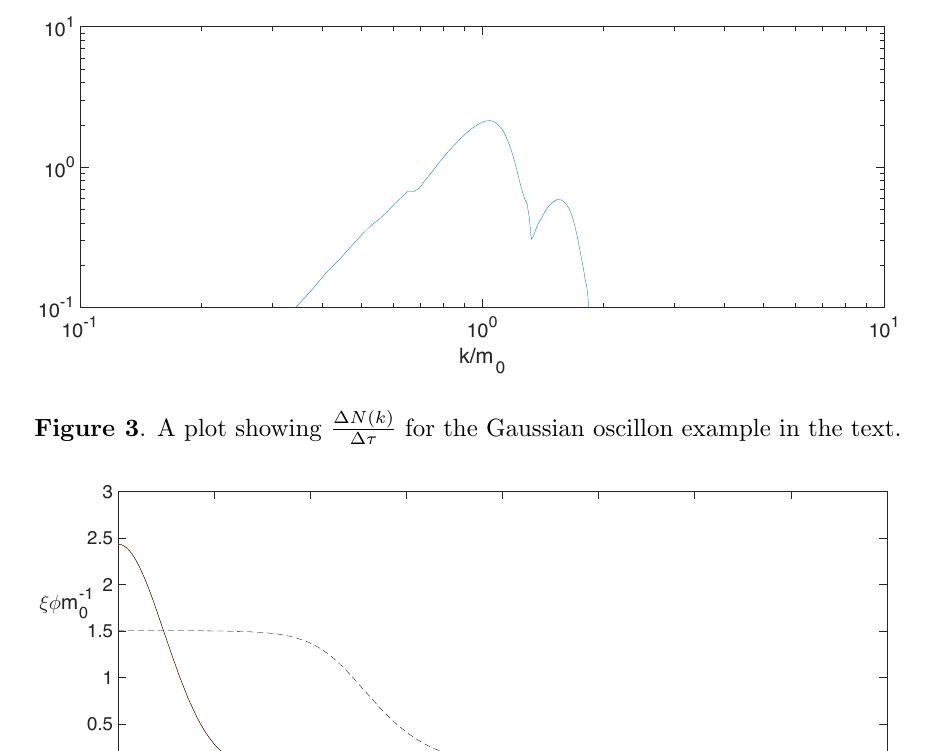
Figure 4 . A plot showing the scalar (cid:12)eld pro(cid:12)les for the (cid:13)at-topped oscillon (dashed line) and the Gaussian oscillon (solid line) examples in the text. Note that they are presented with the Yukawa factor